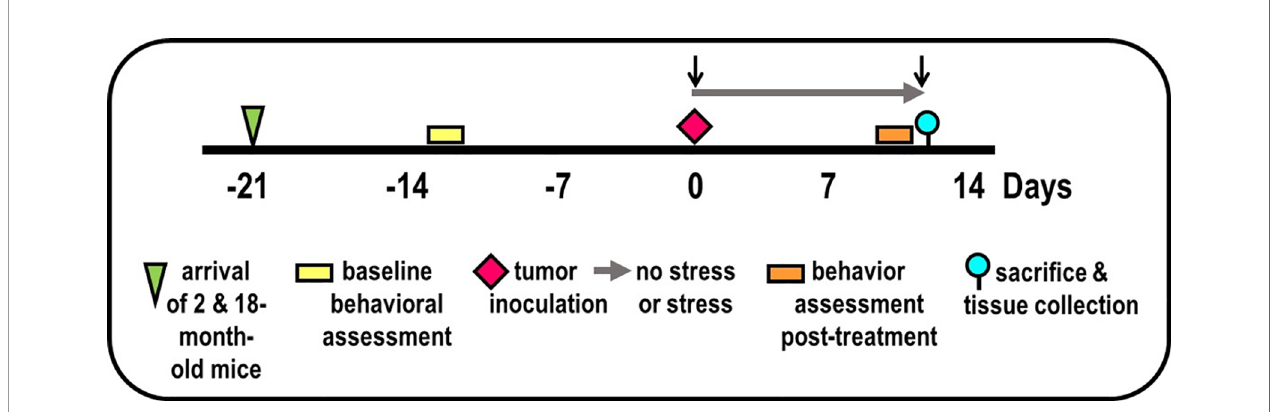
FIGURE 1 | Experimental Design. Experimental timeline of events is illustrated, including mice arrival (triangle), accommodation to vivarium conditions, pre- and post- treatment behavioral testing (yellow/orange bars, respectively), tumor inoculation (diamond), collection of blood by retroorbital bleeding ( ↓ ), and tissue collection for endpoint